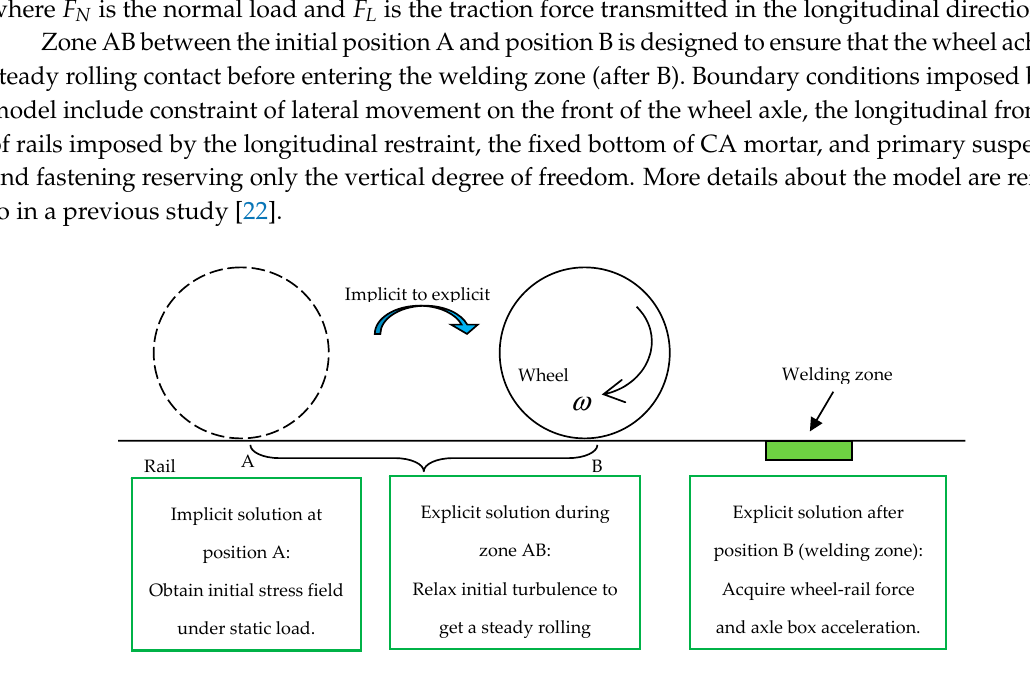
Figure 9. Schematic diagram of the simulation process.